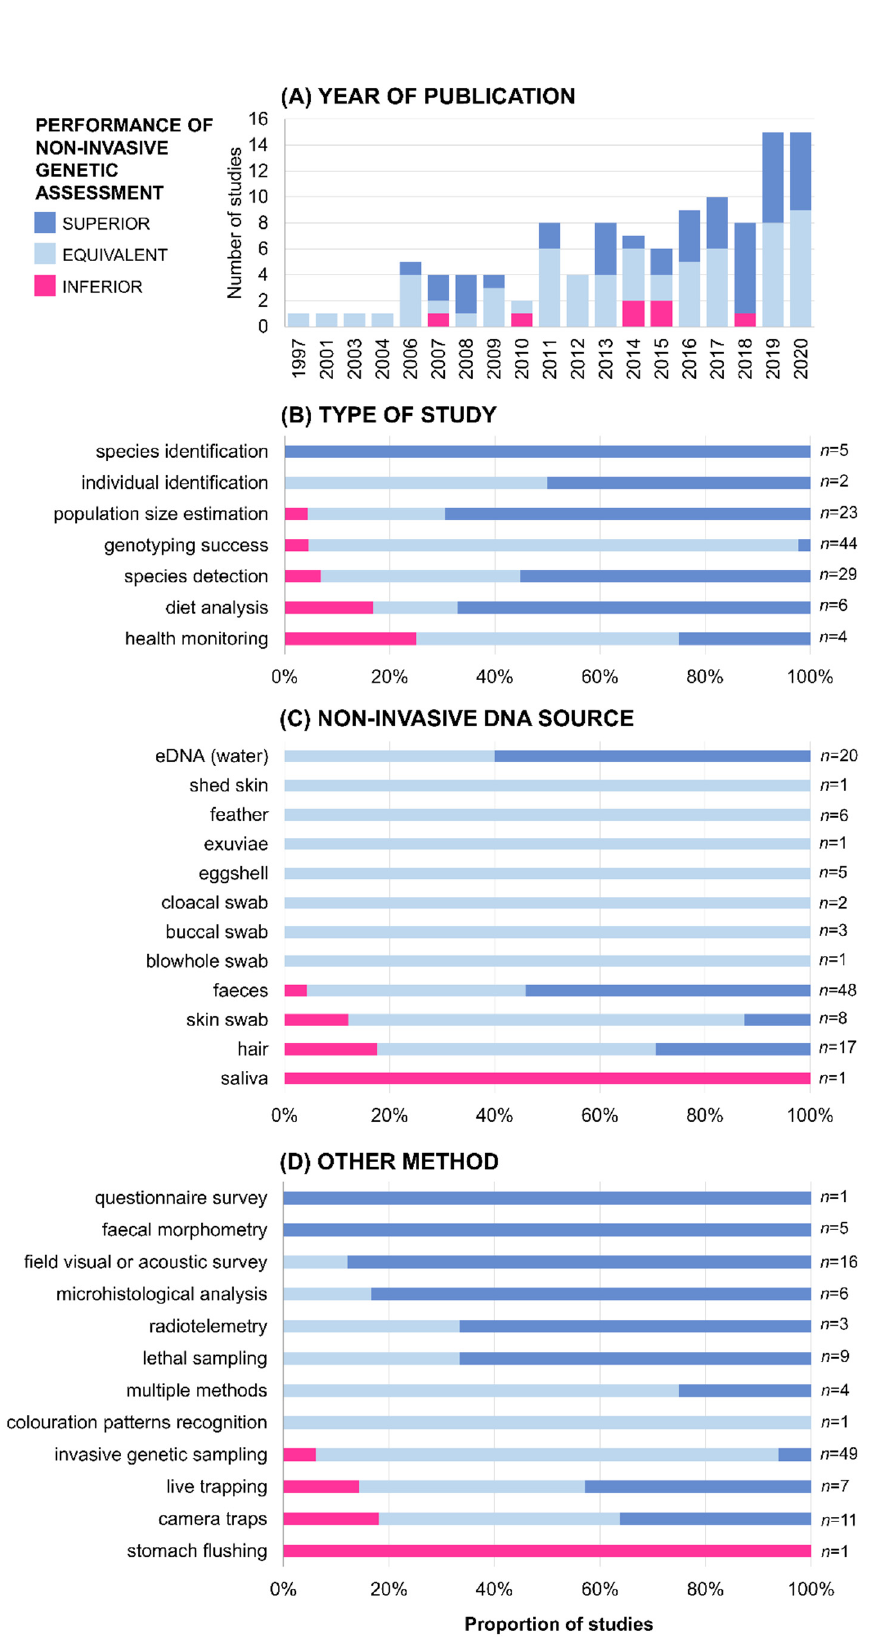
Figure 4. Performance of noninvasive genetic assessment across the 113 studies. ( A ) The number of studies included in the review published in 1997–2020. ( B ) The proportion of studies sorted by their type. ( C ) Sorted by the source of non-invasively obtained DNA sample used. ( D ) Sorted by the method that noninvasive genetic assessment was compared to.